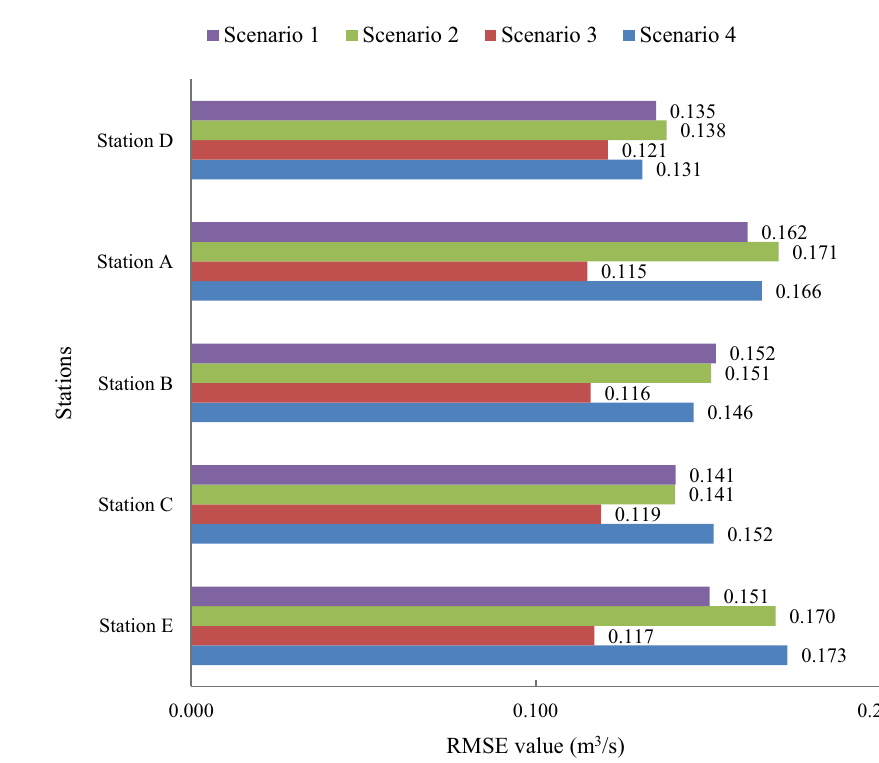
Fig. 5 Summary of sensitiv- ity analysis (SA) results for all scenarios in each study